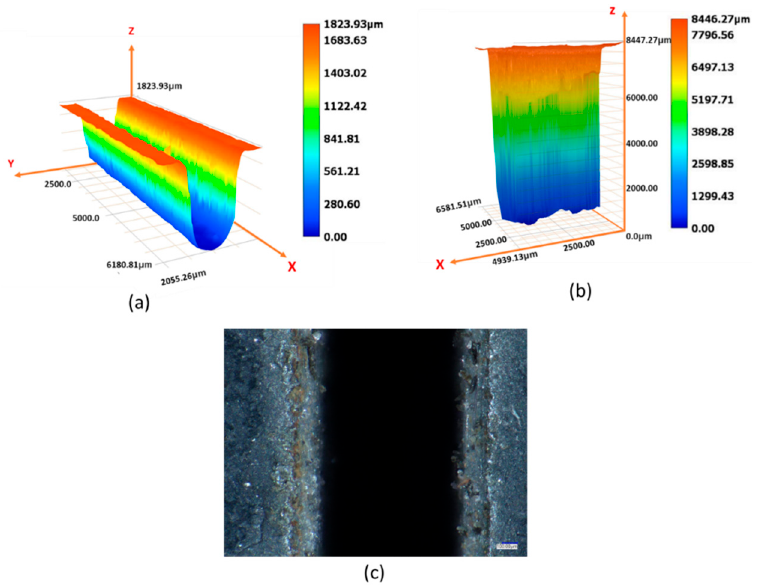
Figure 3. Slots dimension measurements by using a digital microscope for ( a ) a 3D image 3rd ex- perimental slot, ( b ) a 3D image of the 12th slot, and ( c ) top view of the 16th experiment.